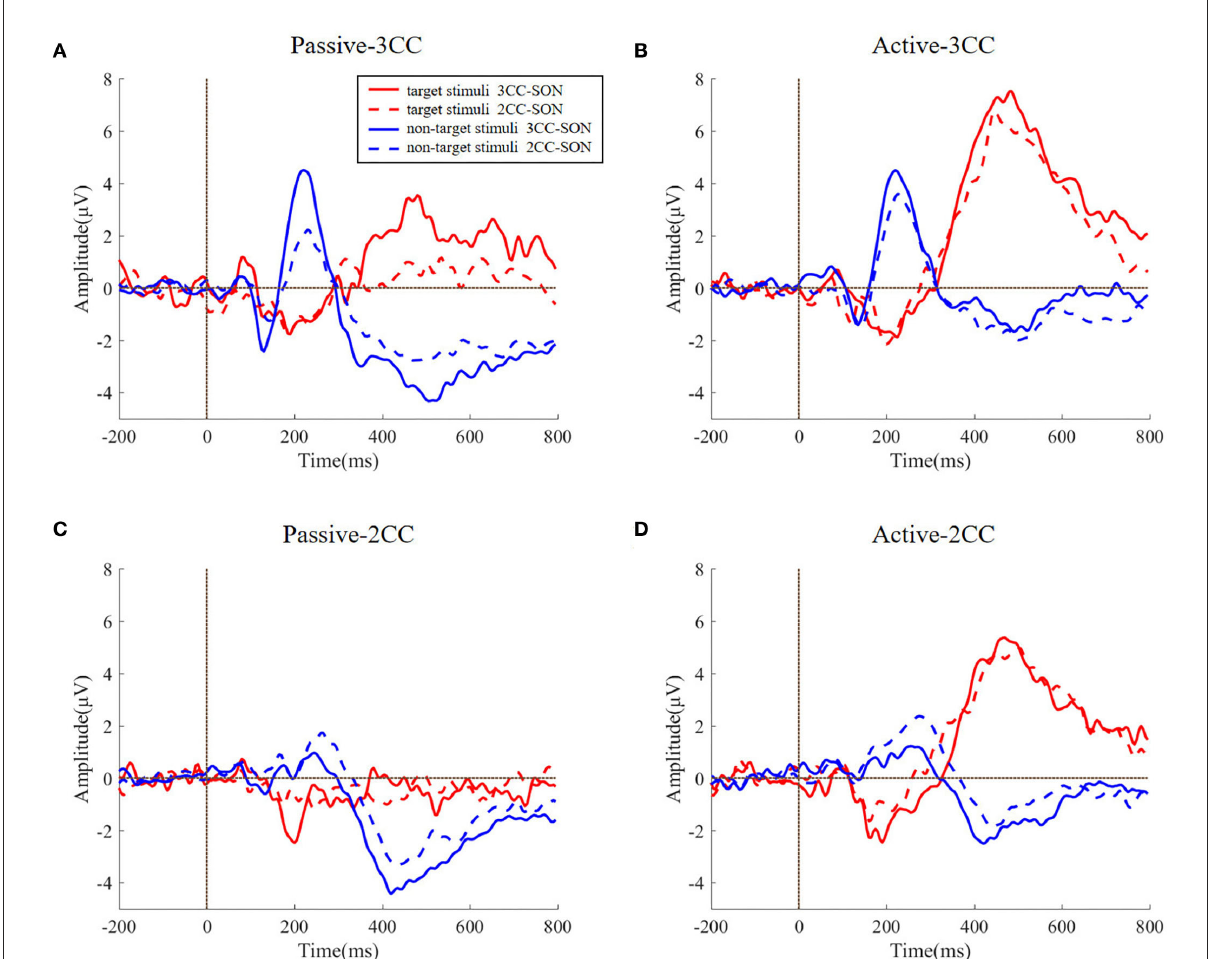
FIGURE5 (A–D) The difference between the ERP evoked by the target stimulus and the non-target stimulus by the length of the subject’s name. The four graphs, respectively, represent four task conditions. Lines of different colors represent different types of stimuli. The abscissa is time (ms) and the ordinate is amplitude ( µ